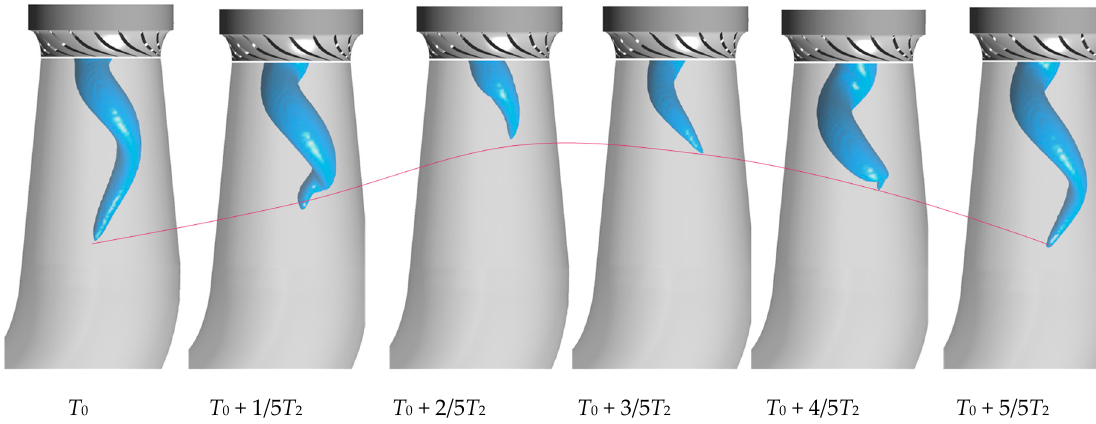
Figure 4. Vortex rope behaviour in typical period structured with iso-surface of vapour volume fraction.